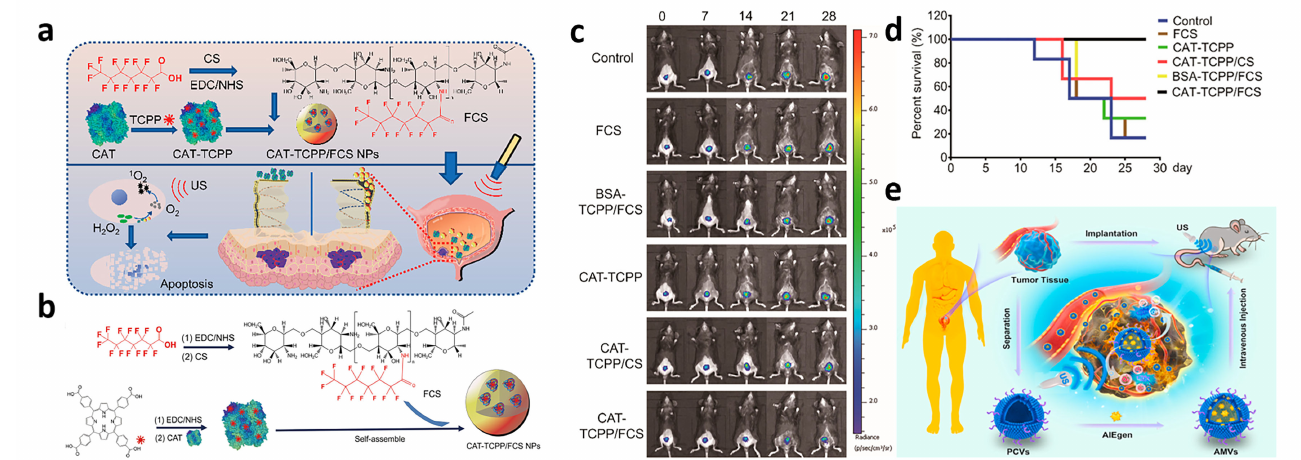
Figure 13. ( a ) Schematic of CAT-TCPP/FCS nanoparticles for H 2 O 2 -responsive enhanced SDT (40 kHz, 3 W/cm 2 ). ( b ) Preparation of CAT-TCPP/FCS NPs. ( c ) In vivo bioluminescence images of MB49-tumor-bearing mice, which were intravesically instilled with FCS, CAT-TCPP, CAT-TCPP/CS NPs, BSA-TCPP/FCS NPs, or CAT-TCPP/FCS NPs after SDT. The bladder was exposed to ultrasonic irradiation (3.0 W/cm 2 , 15 min). ( d ) The cumulative survival rate of mice in different groups after various treatments. (Reprinted with permission Ref. [127]. Copyright © 2020 American Chemical Society.) ( e ) The schematic illustration of the patient-derived microvesicles/AIE Luminogen hybrid system for personalized sonodynamic cancer treatment in patient-derived xenograft (PDX) models. (Reprinted with permission Ref. [128]. Copyright © 2021 Elsevier